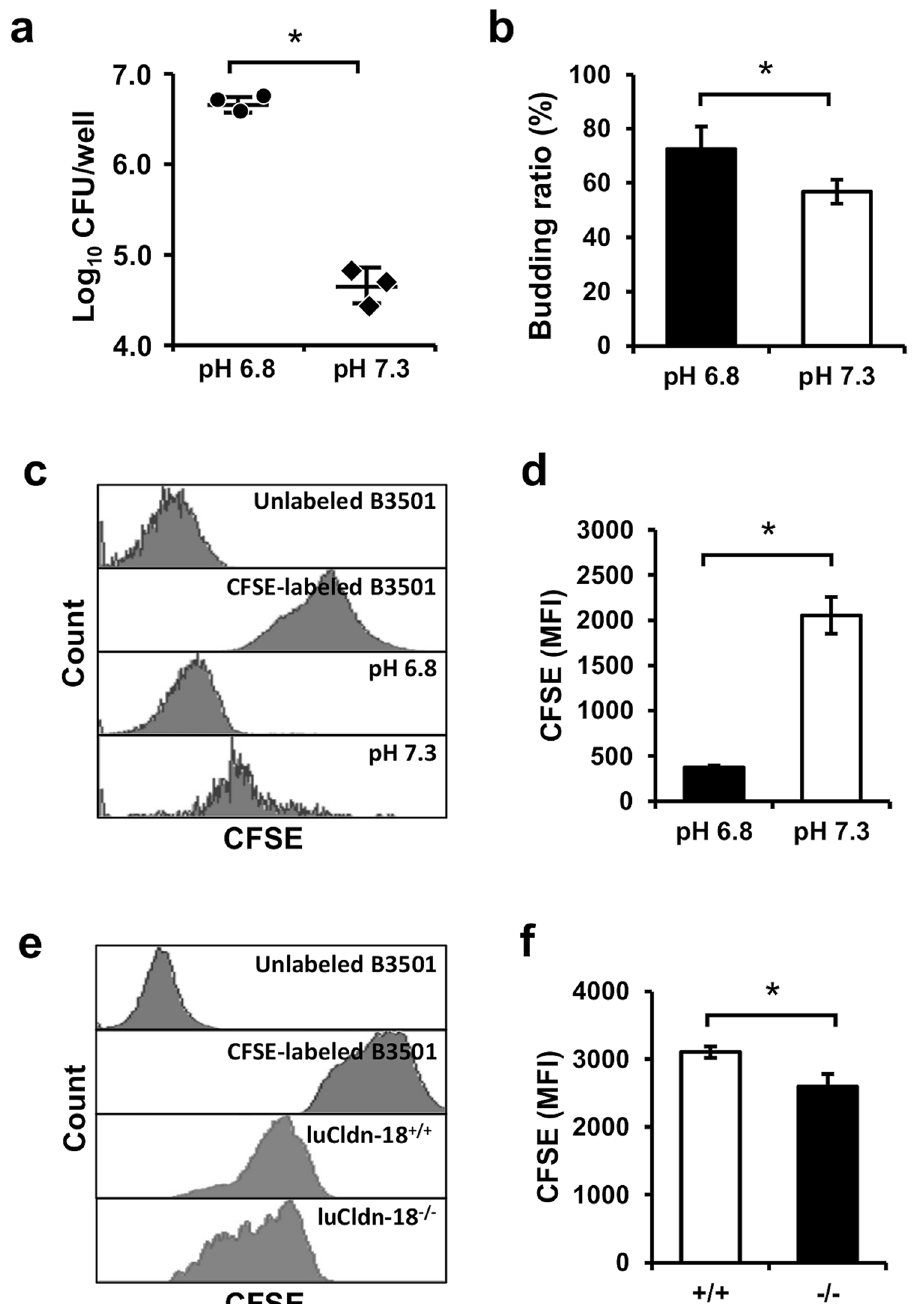
Figure 6. Effect of luCldn-18 deficiency on fungal growth. C. deneoformans was cultured in RPMI 1640 medium containing 20 mM HEPES at 37 °C for 24 h at different pH values (6.8 and 7.3, n = 3 cultures for each condition). ( a ) The number of organisms was counted using a hemocytometer. Each symbol represents a separate culture, and bars indicate the mean ± SD. ( b ) The budding ratio was calculated in the PAS-stained specimens. Each column represents the mean ± SD. CFSE-labeled C. deneoformans was cultured in RPMI 1640 medium containing 20 mM HEPES at 37 °C for 24 h at different pH values (6.8 and 7.3) and cell division was analyzed using flow cytometry ( c , d ). Representative histograms ( c ) and the MFI of CFSE ( d ) are shown. CFSE-labeled C. deneoformans cultured in PDA plates was used as a positive control. Each column represents the mean ± SD. luCldn-18 +/+ (n = 3) and luCldn-18 −/− mice (n = 3) were infected intratracheally with CFSE- labeled C. deneoformans ( e , f ) . BALF cells were prepared at 24 h post-infection. CD45 − CFSE + cells in the alveolar space were defined as fungal cells and analyzed for CFSE fluorescence intensity using flow cytometry. ( e ) Representative histograms are shown. CFSE-labeled C. deneoformans cultured in PDA plates was used as a positive control. ( f ) The MFI of CFSE was calculated. Each column represents the mean ± SD. *, p < 0.05. There were no mice excluded from this